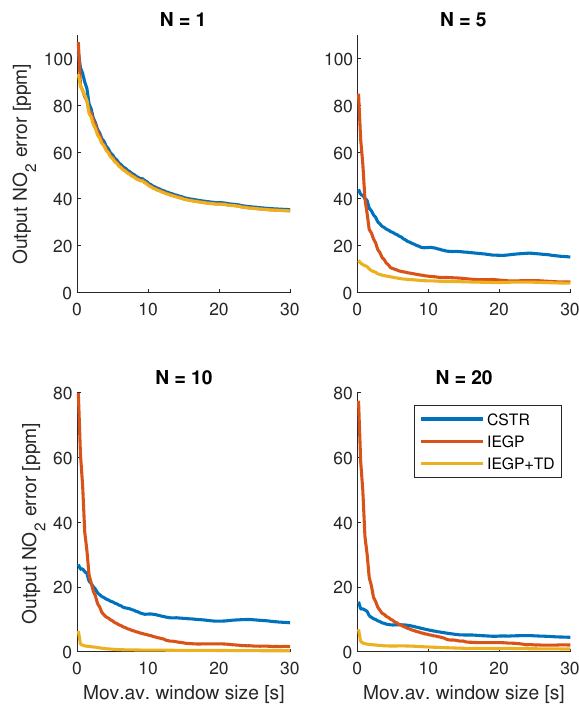
Figure 9. Maximal average error in output NO 2 for different window sizes in the three different models and different N .